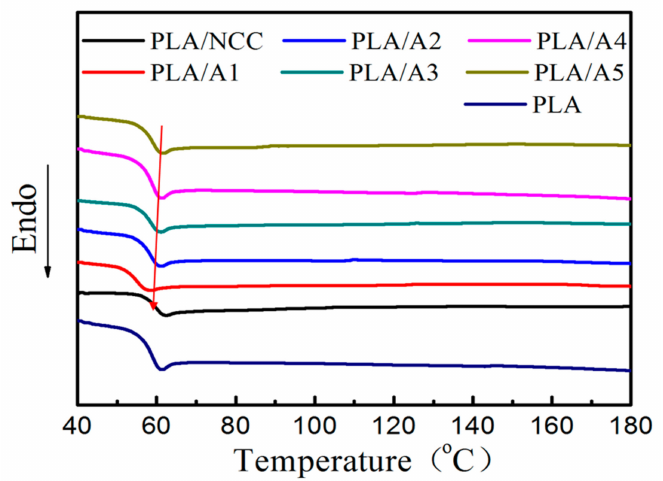
Figure 11. Di ff erential scanning calorimetry (DSC) curves of PLA, PLA / NCC and PLA / NCC-HAP with di ff erent ratios of NCC to